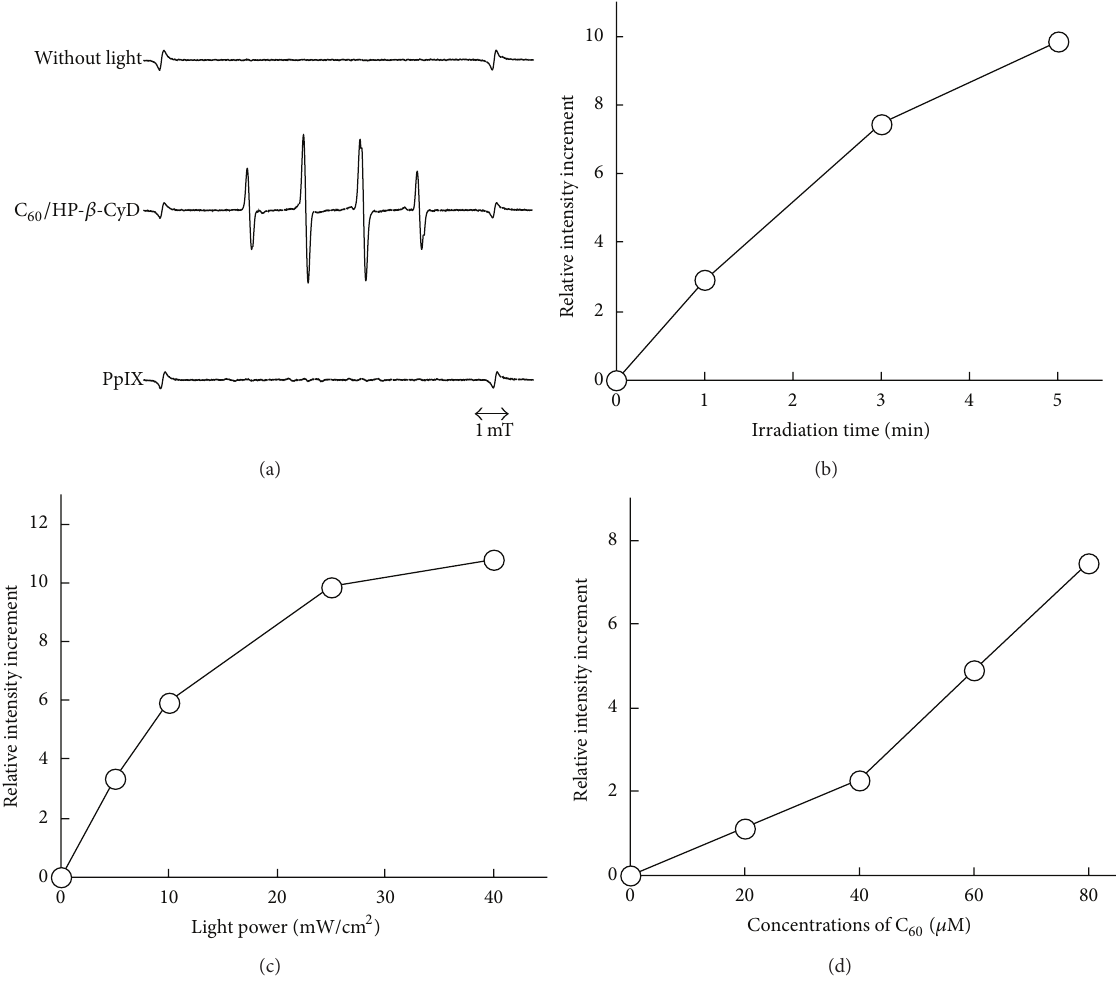
Figure 2: ESR spectra of the DMPO-OH adduct generated in the C 60 /HP- 𝛽 -CyD colloidal solution (C 60 = 40 𝜇 M, light irradiation at 40 mW/cm 2 for 5min) (a). Its relative intensity increment after visible light irradiation (b). Effects of the light power (c) and concentrations of photosensitizers (d) on the generation of O 2∙− . Each point represents the mean ± S.E. of 3